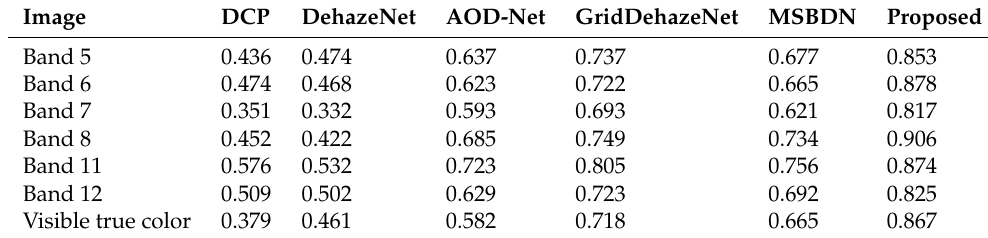
Table 3. Experimental results on different bands: SSIM.